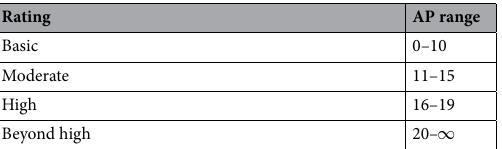
Table 1. Semi-qualitative scale for attack rating. This scaling is adapted with respect to the Common Evaluation Methodology 25 , taking into account the fact that we consider 4 out 5 factors in our analysis. For a more detailed discussion on the attack rating factors see